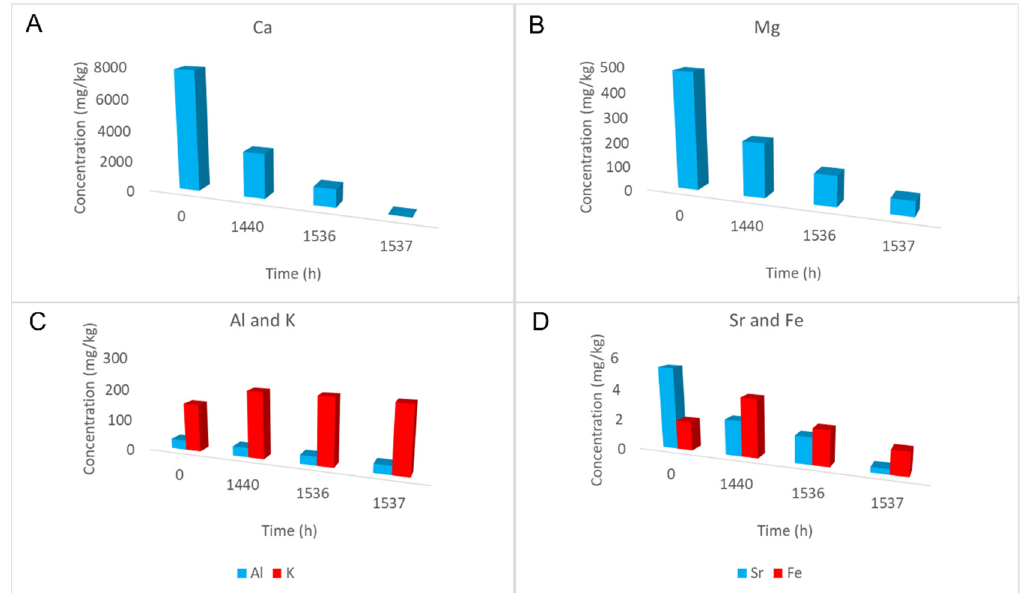
Figure 10. Dissolved concentrations during the CO 2 -brine-rock reaction, where time 0 is before CO 2 injection, and 1537 h is after depressurization. ( A ) Dissolved concentration of Ca, note this decreased below detection at 1537 h. ( B ) Dissolved concentration of Mg. ( C ) Dissolved concentration of Al and K. ( D ) Dissolved concentration of Sr and Fe.